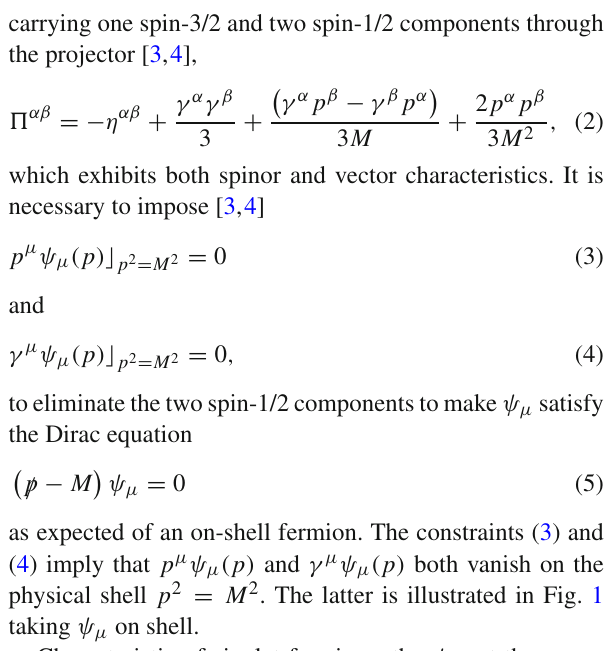
to generate the neutrino Majorana